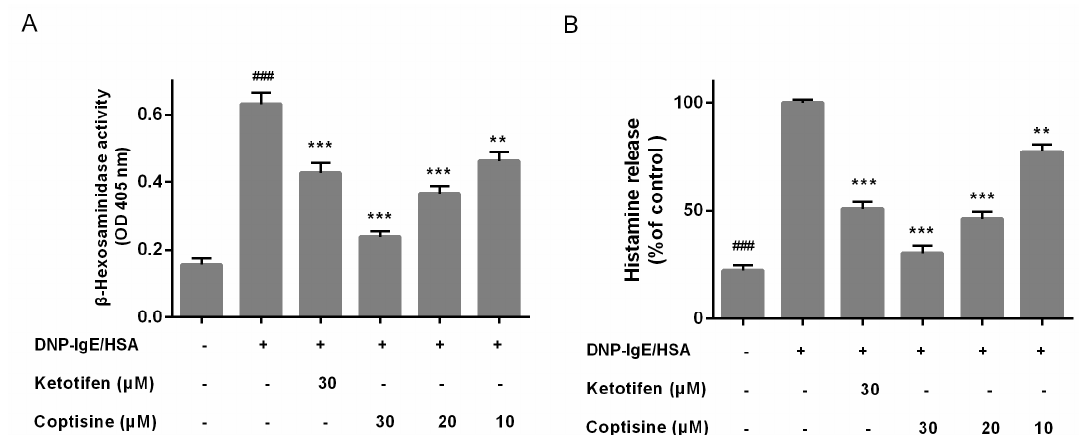
Figure 2. Effect of coptisine on the levels of β-hexosaminidase and histamine from mast cells. Coptisine pretreated (30, 20 or 10 µM) in DNP-IgE/HSA sensitized RBL-2H3 cells. ( A ) The level of β-hexosaminidase; ( B ) The level of histamine (the absolute concentration of histamine for control is 210.64 ng/mL). All data were expressed as the mean ± SE. ** p < 0.01, *** p < 0.001, in comparison with control group; ### p < 0.001 in comparison with control group.